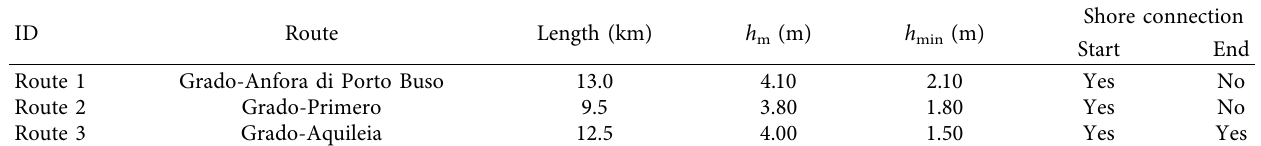
Figure 2: Routes of interest for passenger transportation in the Grado Lagoon. Table 1: Main characteristics of the passenger transportation